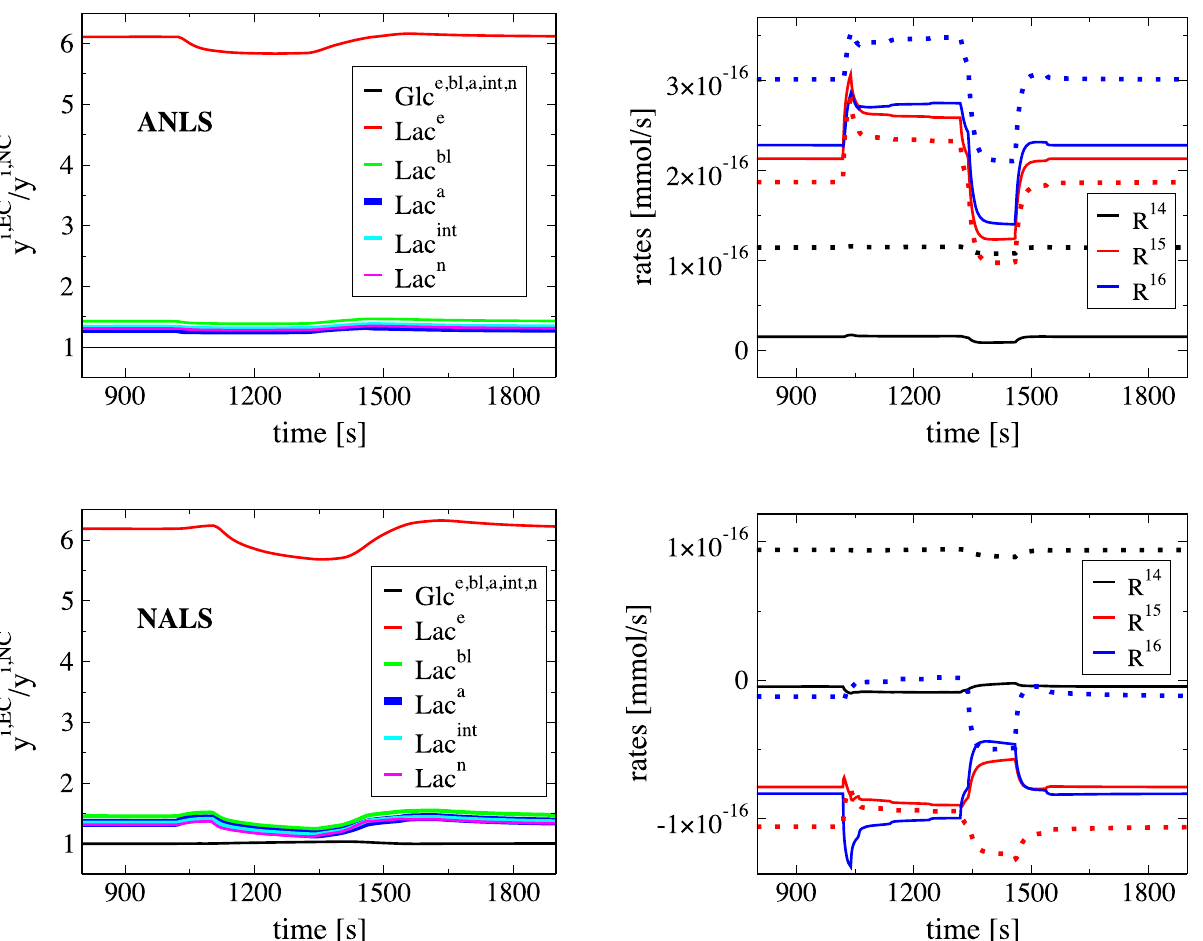
Fig 8. Comparison of the metabolites concentrations and the rates R 14 , R 15 and R 16 in moderate exercise conditions with the normal ones. Ratio y i , EC / y i , NC of various concentrations under exercise ( y i , EC ) and normal ( y i , NC ) conditions (left) and profiles of the net reaction rates R 14 = R 14, f − R 14, b , R 15 = R 15, f − R 15, b and R 16 = R 16, f − R 16, b (right), during neuronal activation for the ANLS (top) and NALS (bottom) cases, for the moderate exercise scenario. In the figures on the right panels solid/dashed lines denote NC/EC,